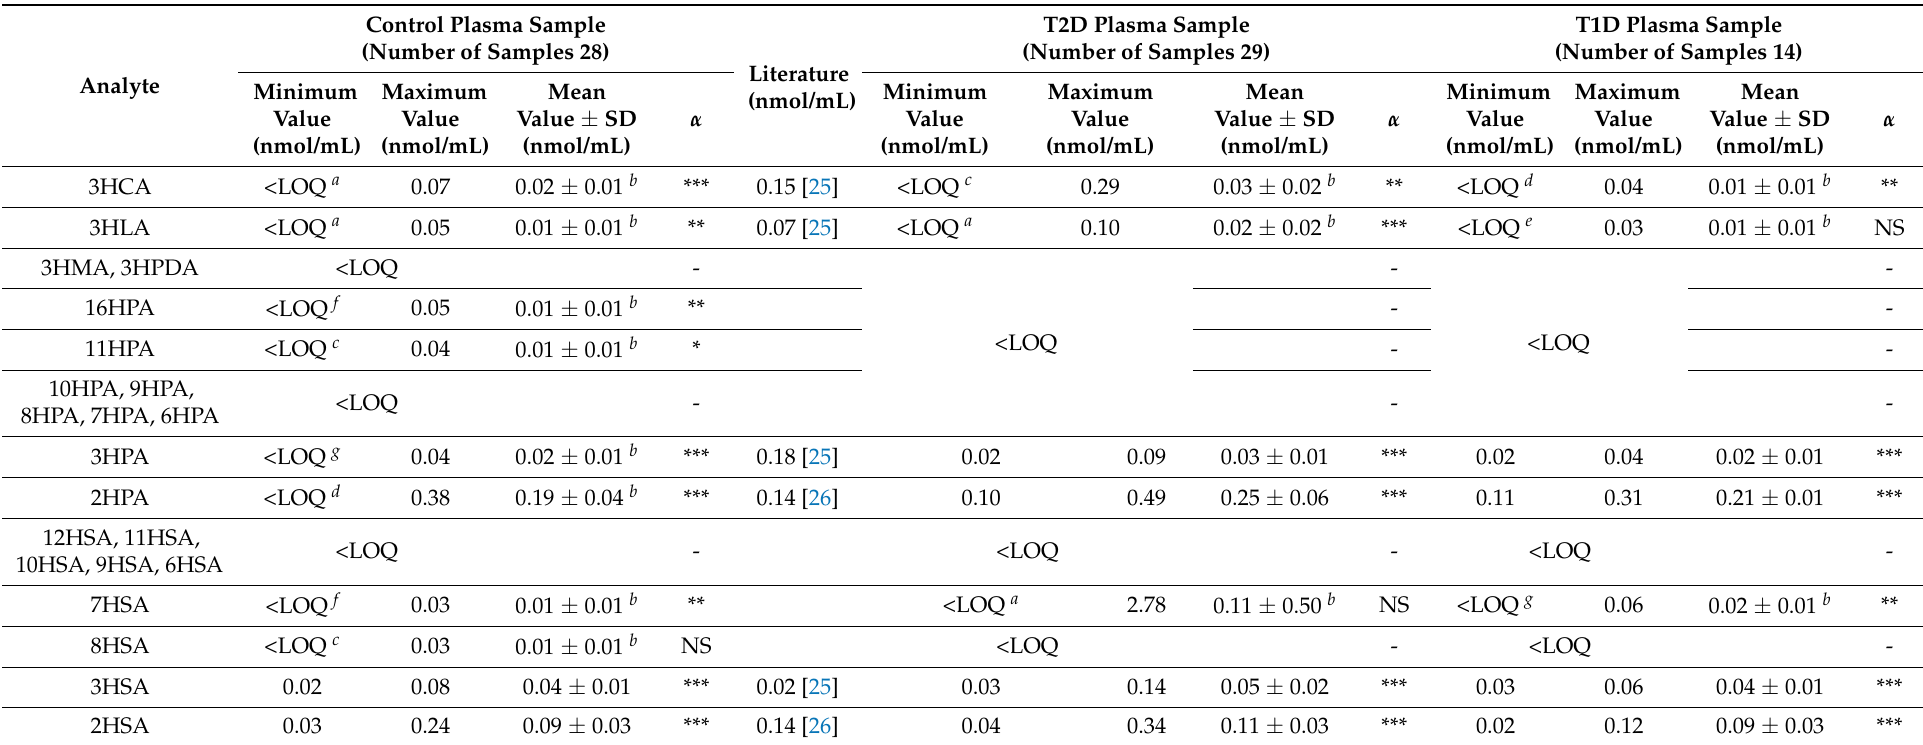
Table 1. Contents of free SHFAs in plasma samples